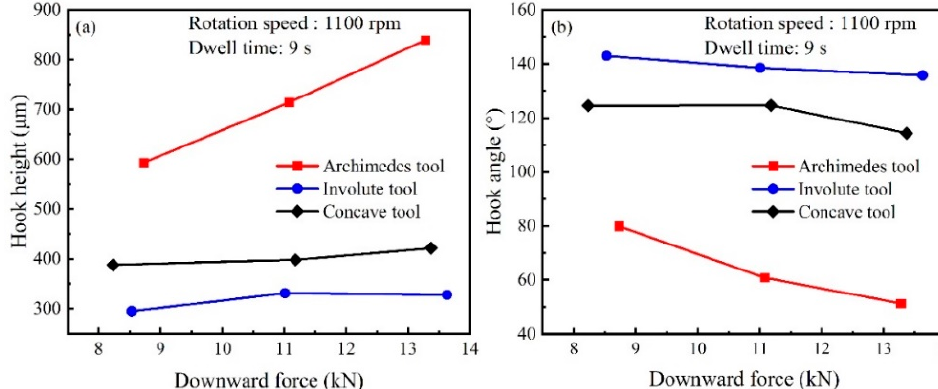
Figure 8. Effects of the downward force on ( a ) hook height and ( b ) hook angle. Figure 8. E ff ects of the downward force on ( a ) hook height and ( b ) hook